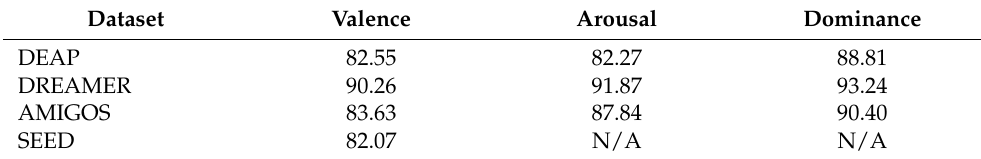
Table 8. Accuracy for male subjects with the channels selected with the